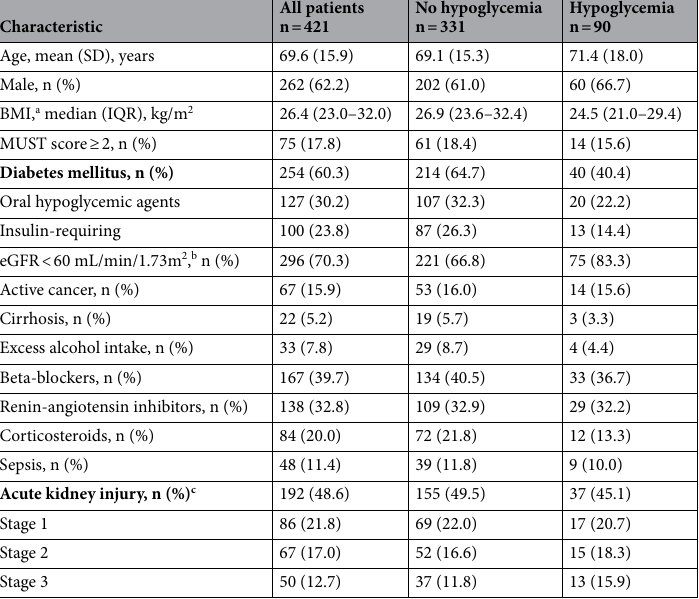
Table 1. Patient characteristics by hypoglycemia status. a Missing BMI observations, n = 11. b Equivalent to KDIGO chronic kidney disease stage 3 or higher. c Excluding 26 chronic dialysis patients who cannot be evaluated for AKI. Abbreviations: MUST, Malnutrition universal screening tool.